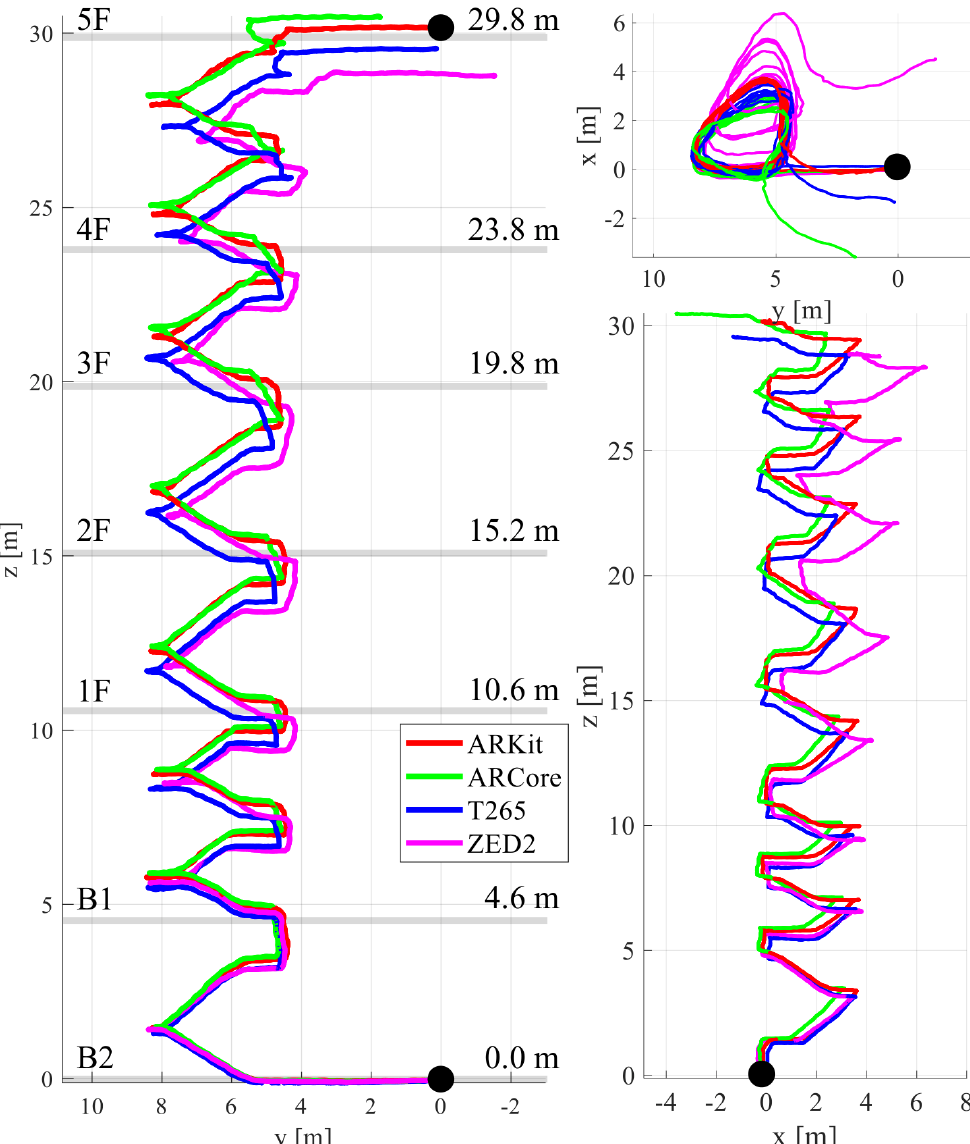
Figure 7. Comparison of the four VIO systems on multi-story stairs from the second basement floor (B2) to the fifth floor (5F). The side ( left ), front ( bottom right ), and top ( top right ) views of the estimated VIO trajectories are shown. ARKit had the camera motions that were most consistent with the shape of the stairs, and it only matched the start and end points, which are marked in the black